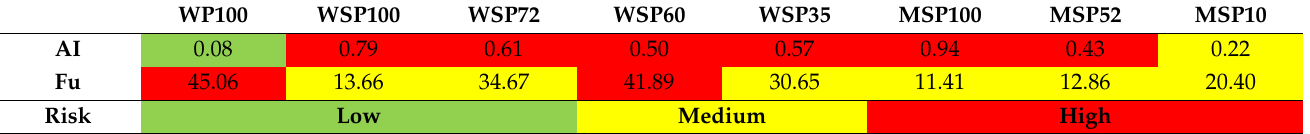
Table 7. Indices values to analyse